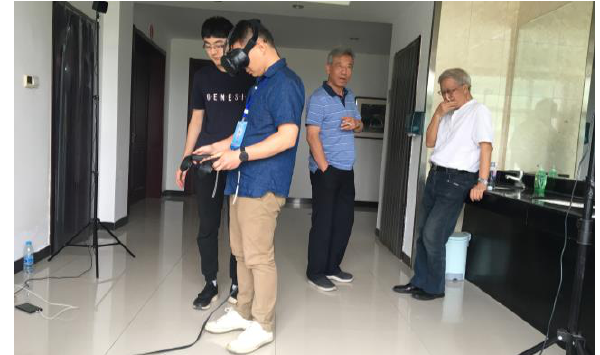
Figure 5. Experience VR at the seminar